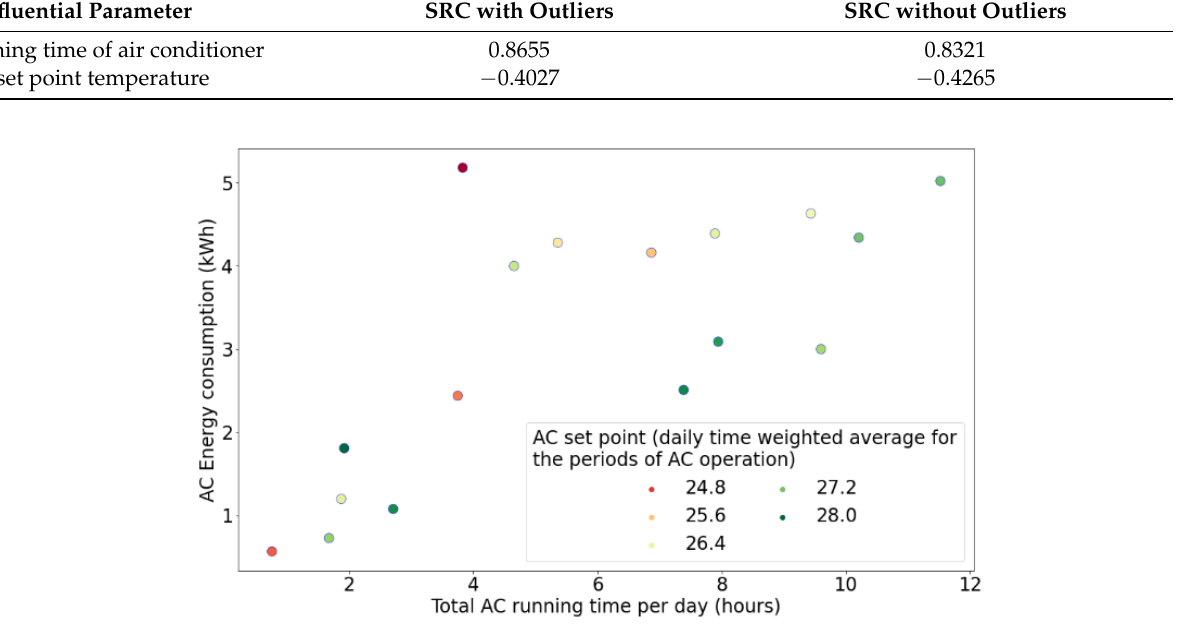
Figure 9. Relationship between AC energy consumption and total running time of the air conditioner and periodic average of AC set point temperature.